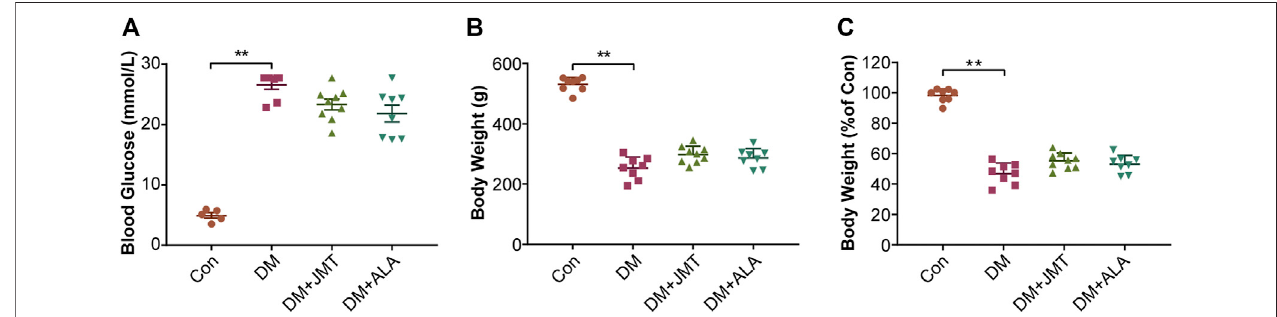
FIGURE 1 | Effects of JMT on blood glucose levels and body weights in diabetic rats (A) Blood glucose (B) body weight and (C) body weight levels relative to the normal control group were measured at 12 weeks after STZ. The data are presented as mean ± SEM (n (cid:1) 8 per group). ** p < 0.01 vs Con group. Con, control; DM, diabetes mellitus; ALA, alpha-lipoic